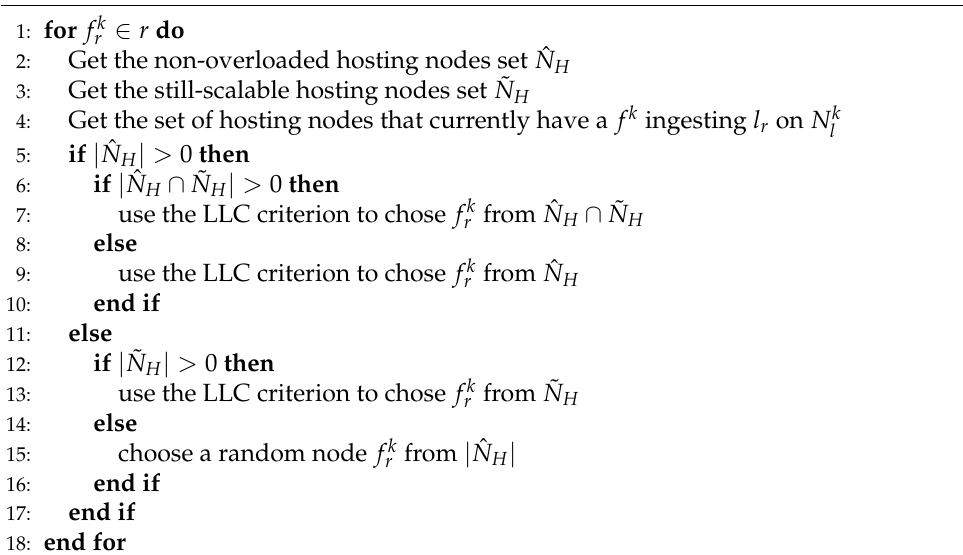
Algorithm A1 GP-LLC VNF Assignation